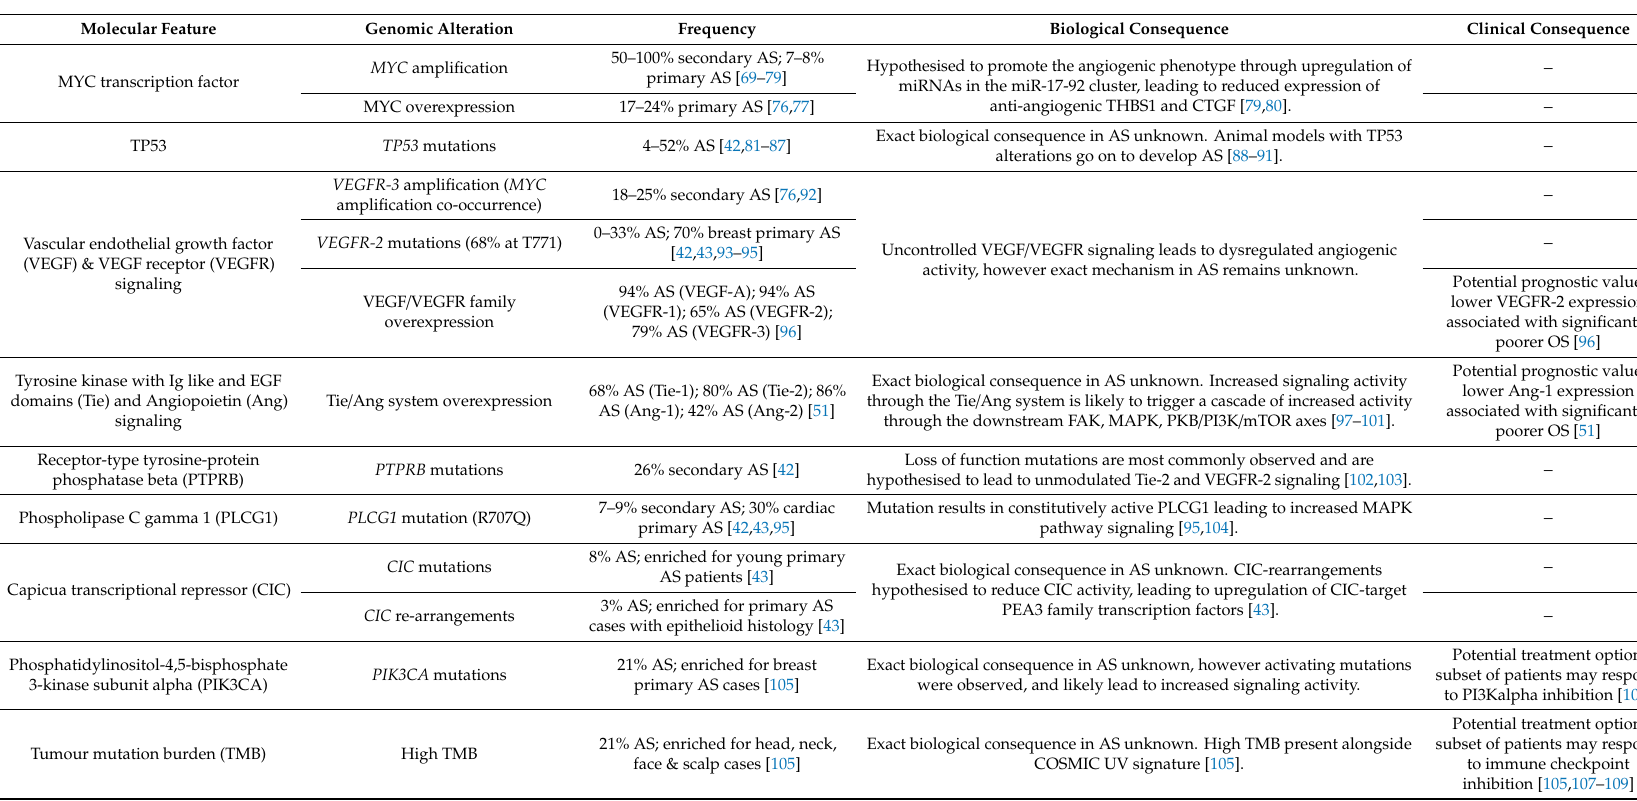
Table 2. Summary of the key molecular features of angiosarcoma, with the frequency of genomic alteration, and if known the biological and clinical